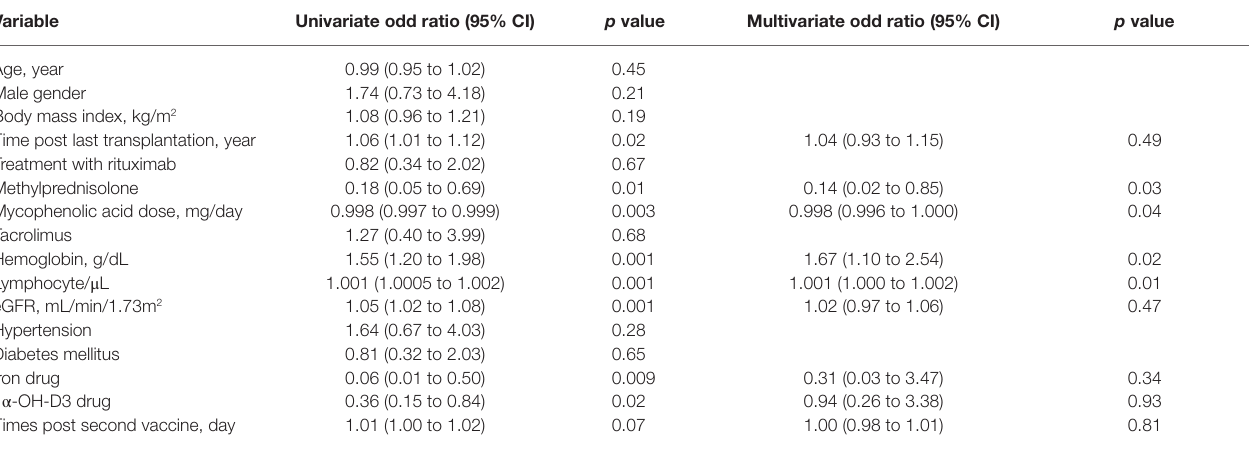
TABLE 2 | Factors associated with antibody response by univariate and multivariate logistic regression models. Variable